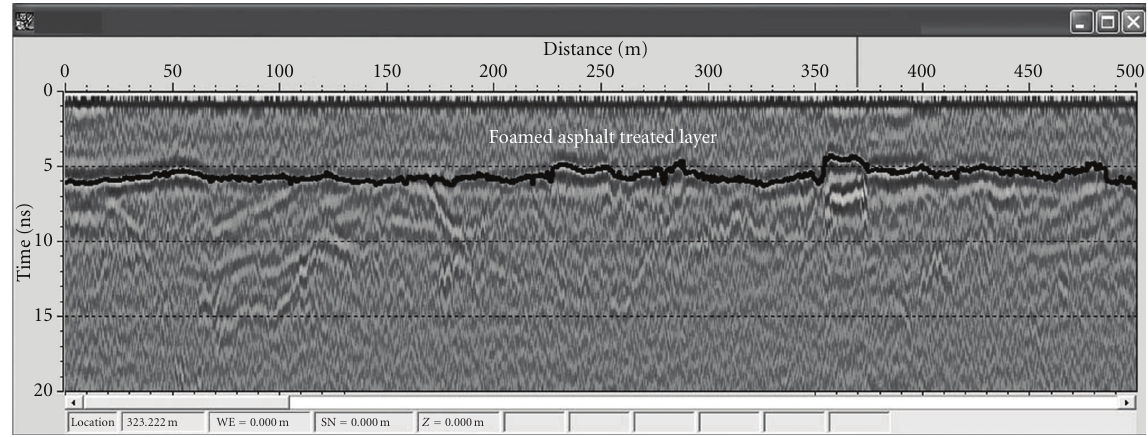
Figure 10: GPR data interpretation for the thickness estimation of stabilized with foamed asphalt layer.